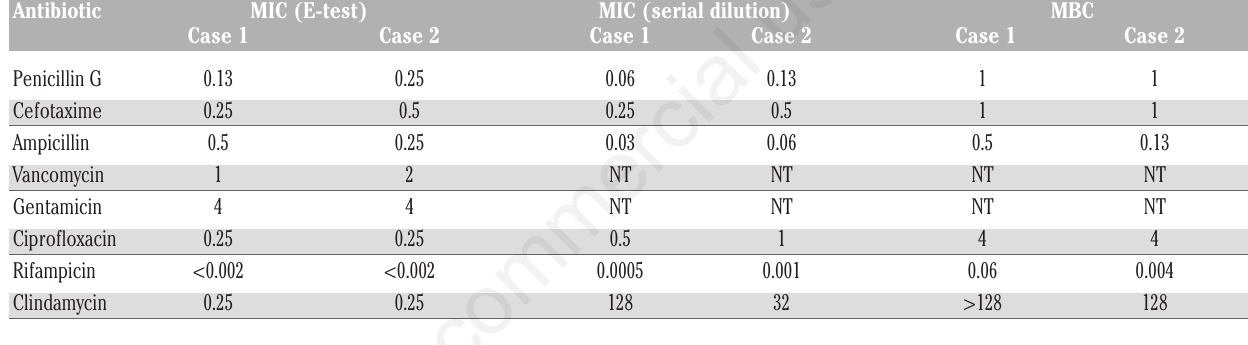
Table 1. Antibiotic susceptibility of the two isolates. Concentrations shown as µg/ml. Minimal inhibitory concentration (MIC), was measured by E-test and serial dilution in nutrient broth. 19 MBC (minimum bactericidal concentration, the lowest antibiotic concentra- tion to cause a reduction in colony forming units by 99.9% in 24 hours) was also tested in nutrient broth, with bacteria then plated on agar plates to measure the number of surviving cells. MIC in serial dilution and MBC was not tested (NT) for vancomycin and gen- tamicin.